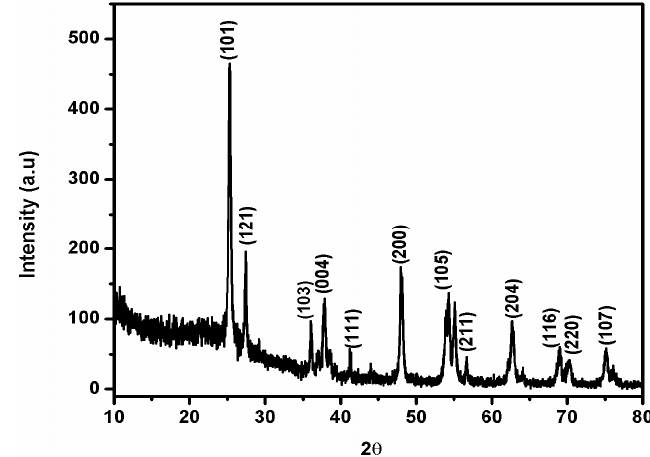
Figure 1. XRD pattern of Fe-doped TiO 2 nanoparticles.